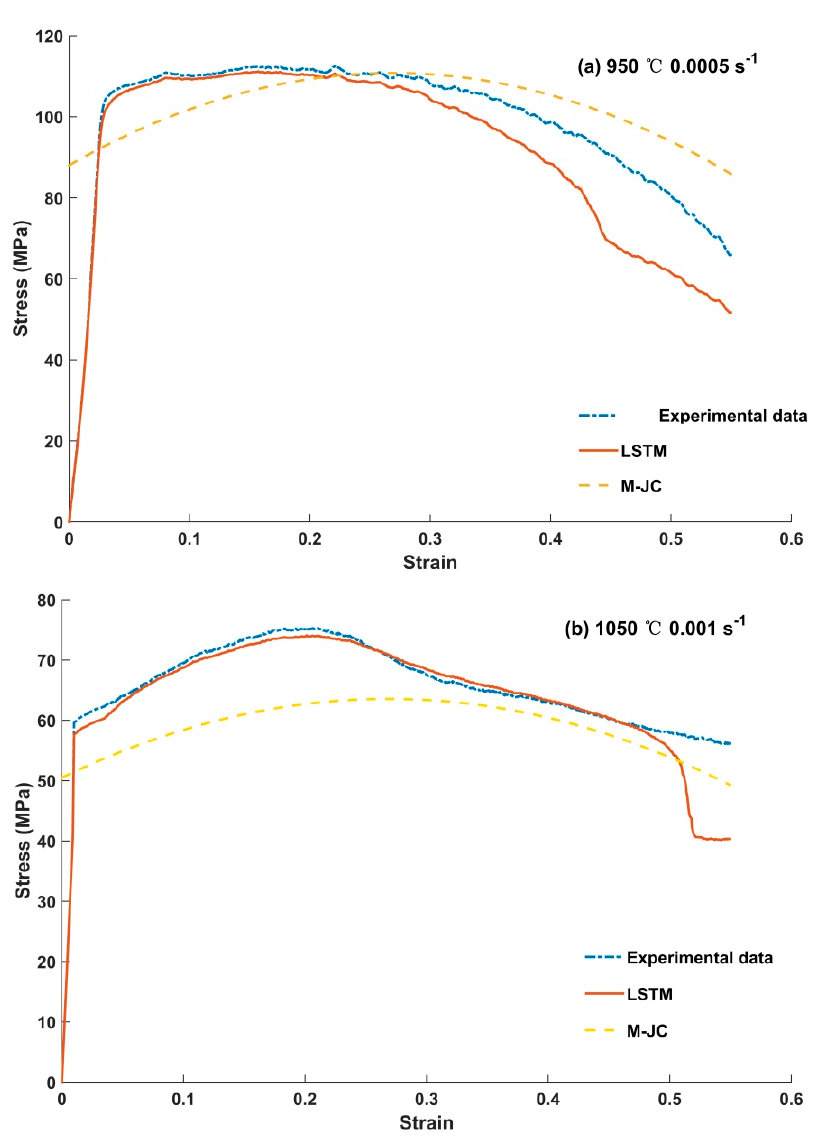
Figure 6. Prediction results of LSTM constitutive model and modified Johnson-Cook (M-JC) constitutive model. ( a ) 950 °C ; ( b ) 1050 °C. Table 3. Comparison of prediction performance between LSTM and M-JC in plasticity stage.